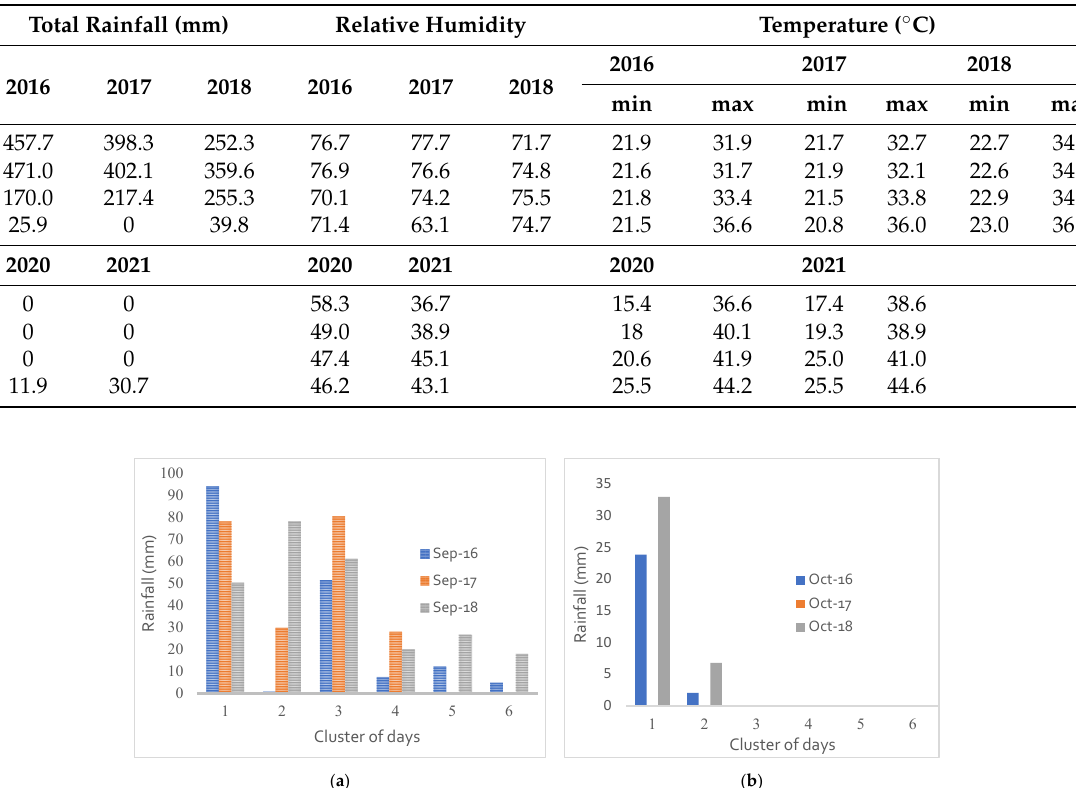
Table 1. Meteorological data during the experiment period.